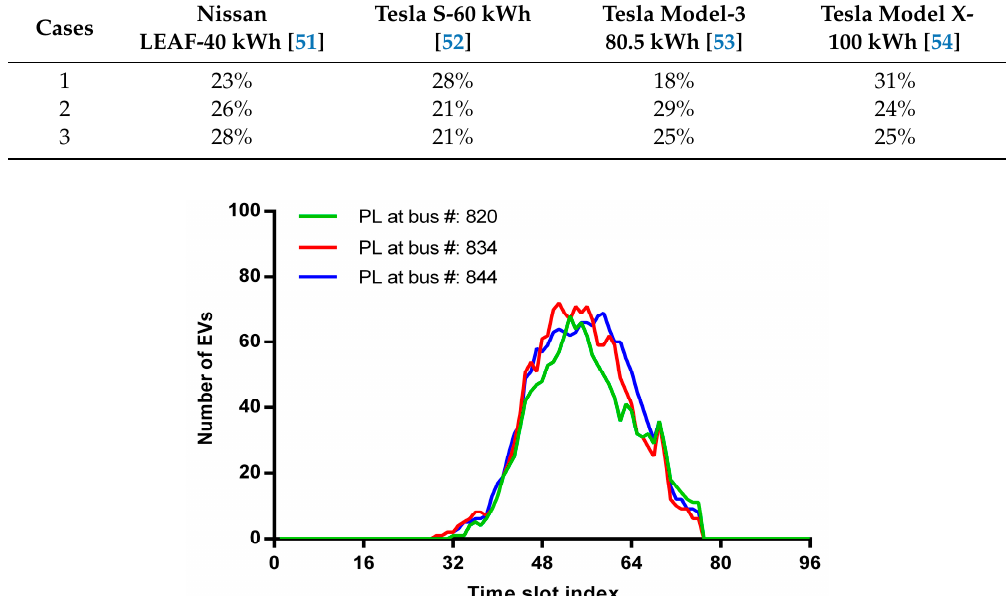
Figure 10. Time varying occupancies of EVs in three different PLs connected to the three buses.